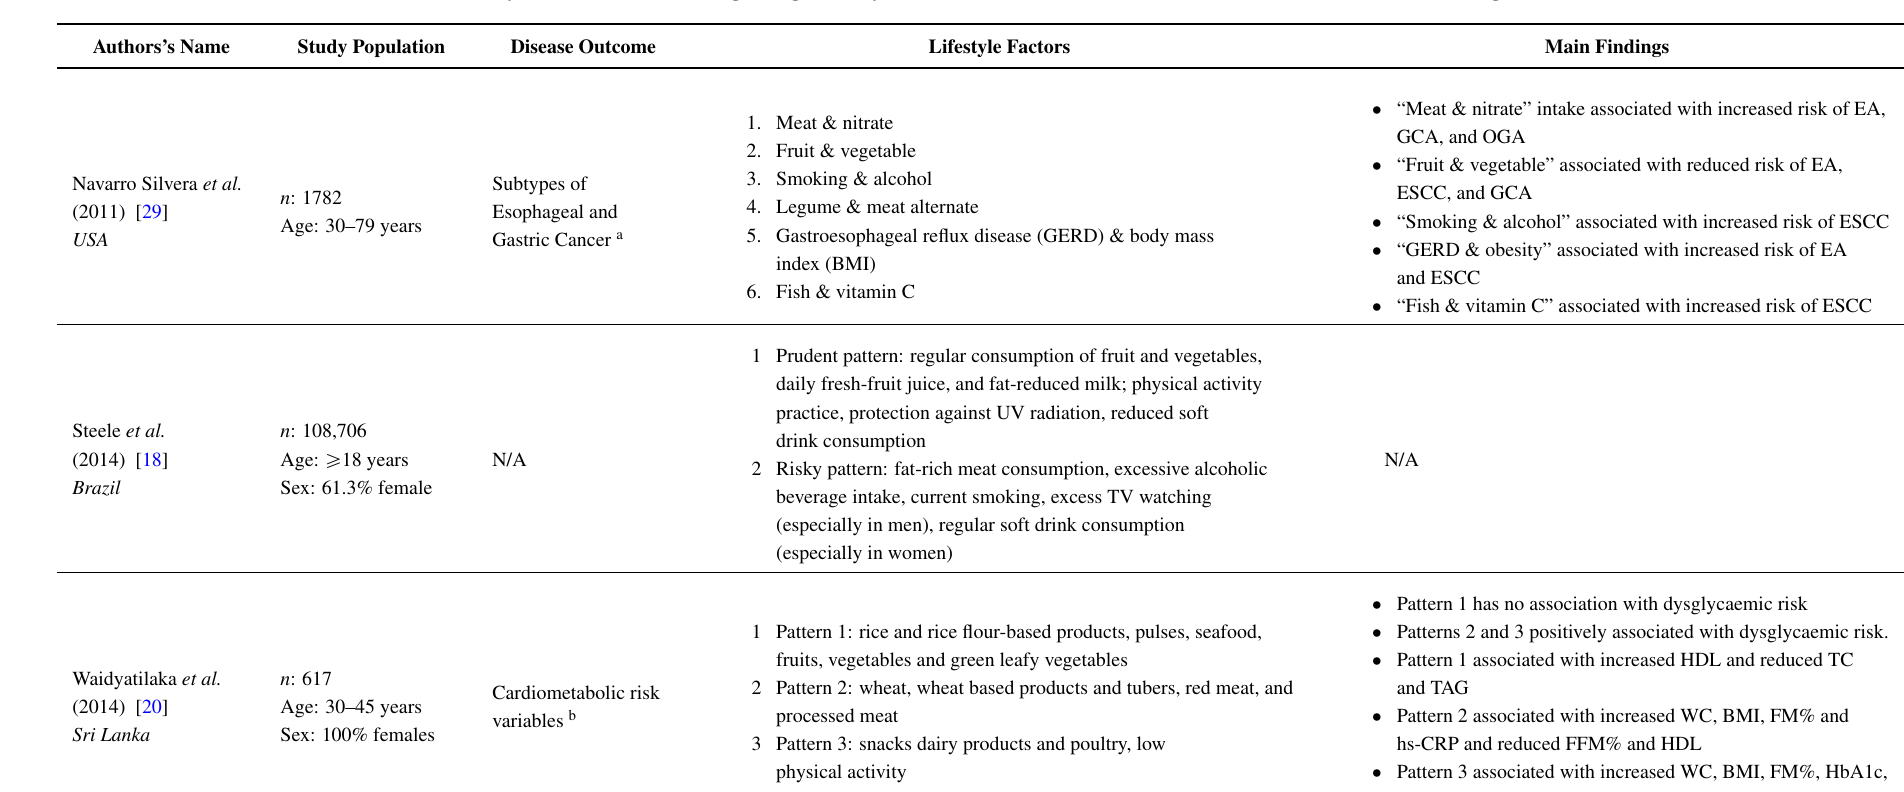
Table 5. Summary of studies investigating lifestyle factors and their associations with disease among